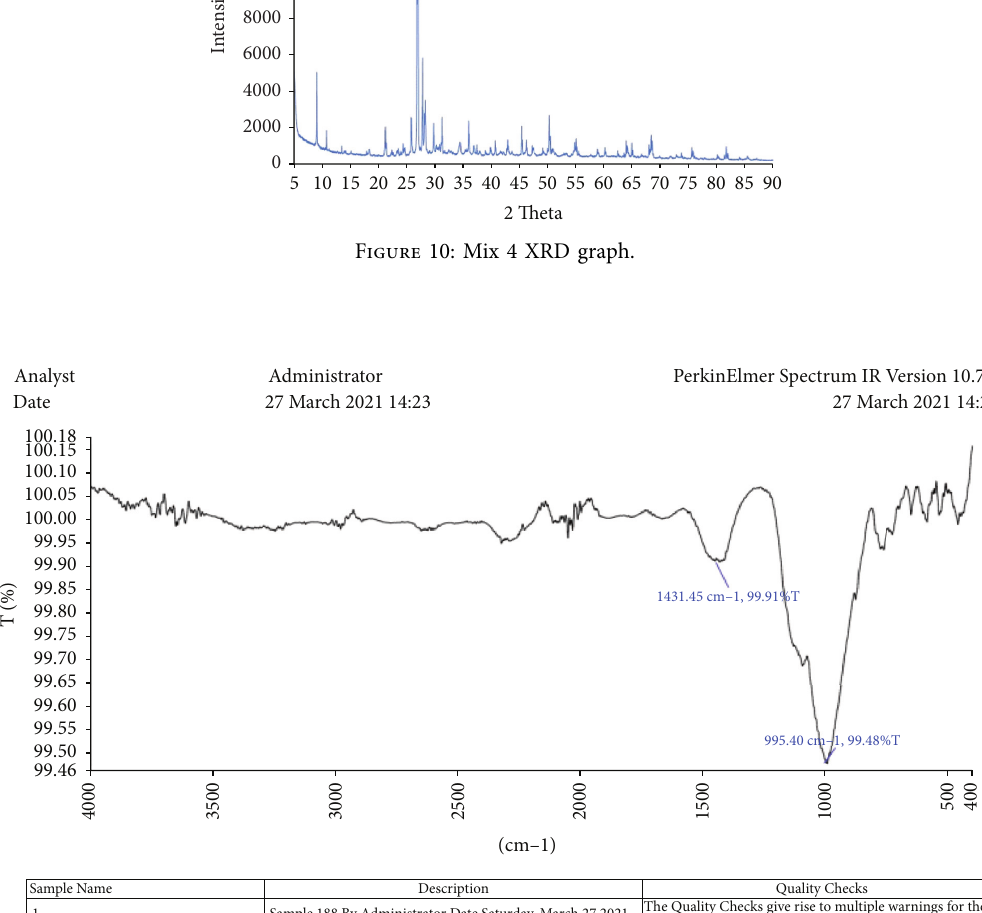
Figure 11: Mix 2 FT-IR pattern.